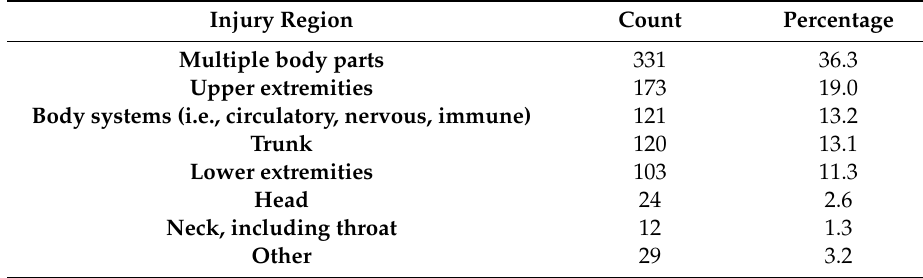
Table 3. Reported specific injury